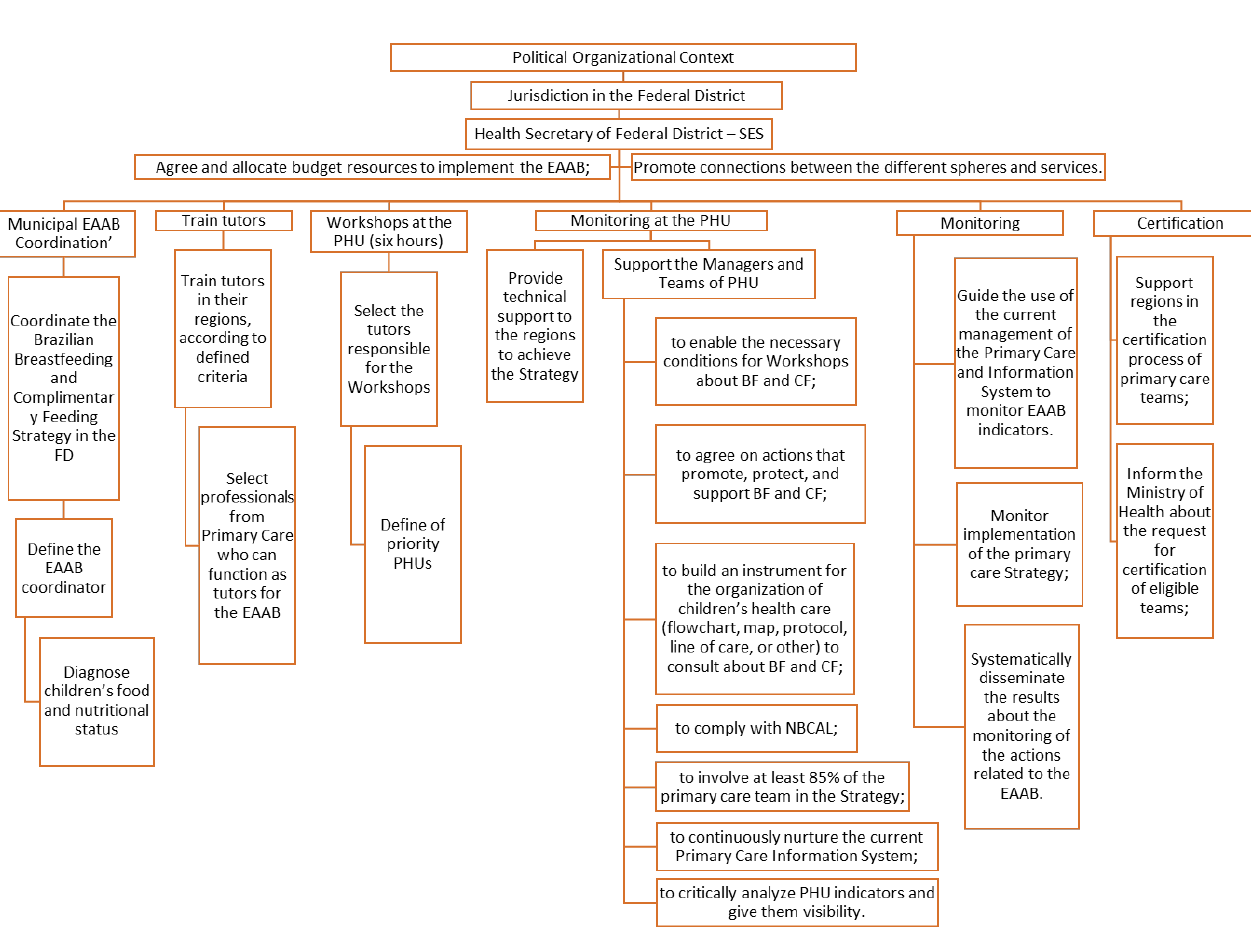
Table 2. Classification of indicators in the categories of Government Triangle, EAAB, Brasília, FD, 2018.